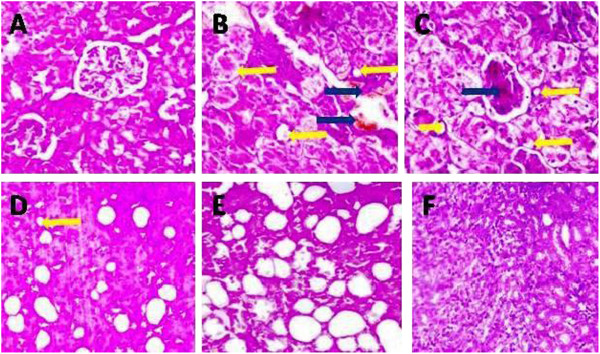
Effect of umbelliferone β-D-galactopyranoside (UFG) on histopathology of kidney normal and STZ treated groups rat: (A) Normal control: Average size of glomerulus shown in the normal group rat histopathology. (B) Diabetic control: Inflammatory cells in blood vessels (blue arrow) and fat deposition (yellow arrow) shown in the histopathology of diabetic control group rat. (C) UFG I (10 mg/kg): Some inflammatory cell in blood vessels (blue arrow) and deposition of fat (yellow arrow) found in the histopathology of UFG I (10 mg/kg) treated groups’ rat. (D) UFG II (20 mg/kg): Only fat deposition (yellow arrow) shown in the histopathology of UFG II (20 mg/kg) treated group rat. (E) UFG III (40 mg/kg): Histopathology of dose UFG (40 mg/kg) treated group rat shown average size of glomerulrs but slightly bigger in size as compared to the normal control. (F) Glibenclamide (10 mg/kg): Histopathology of glibenclamide treated group animal shown the histopathology similar to the normal kidney. The samples were obtained from the same liver anatomical regions. For each group, 6 rats were examined and 80 pictures were taken. The above picture for each group was chosen randomly from the 80 pictures in this group. Original magnification, 40 × .